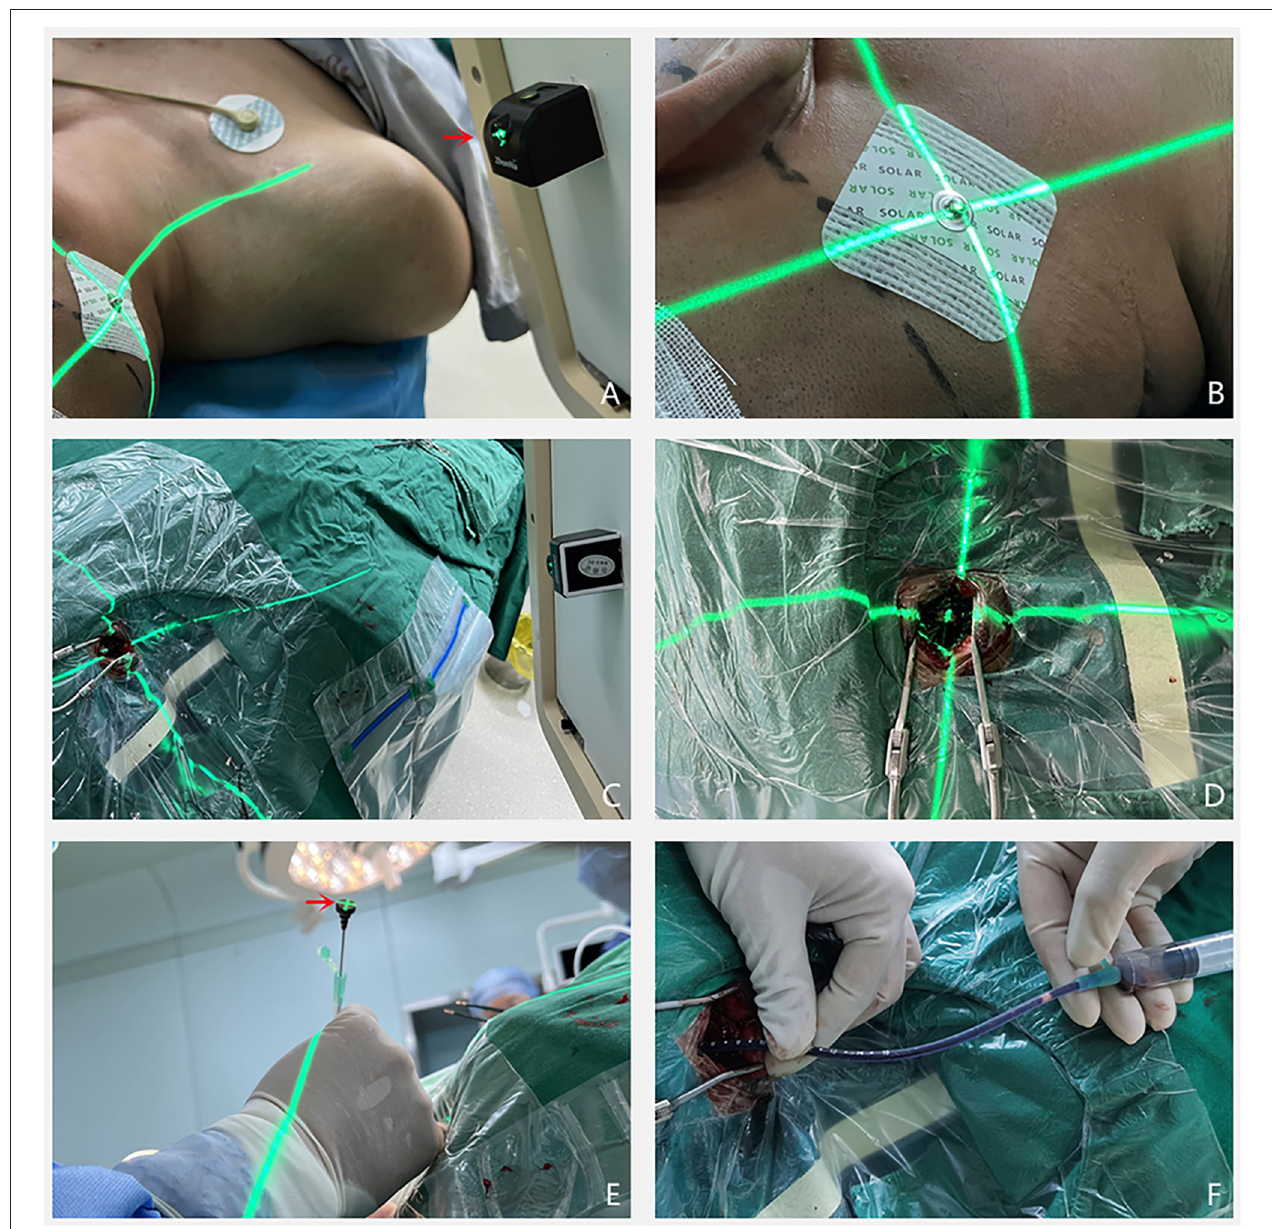
FIGURE 3 | (A,B) The laser transmitter (pointed by the red arrow) was placed on the C-shaped arm and adjusted at a predetermined angle, so that the center of the laser points to the percutaneous puncture point, and the direction of laser irradiation is the puncture direction. (C–E) The scalp was incised with the percutaneous puncture point as the center, and the cortical brain tissue was exposed in the direction of laser emission. The tip of the punctured tube pointed to the intersection of the laser and the cortical brain tissue, and the end of the punctured tube always coincided with the center of the laser. (F) The needle was punctured to a predetermined depth, after which a 5ml syringe was used to slowly aspirate a dark red hematoma to confirm that the drainage tube was located in the hematoma